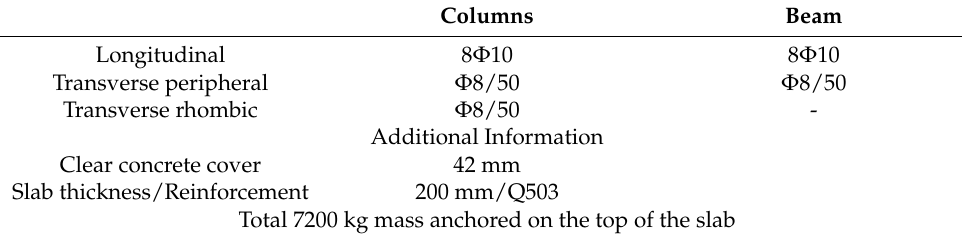
Table 4. Reinforcement